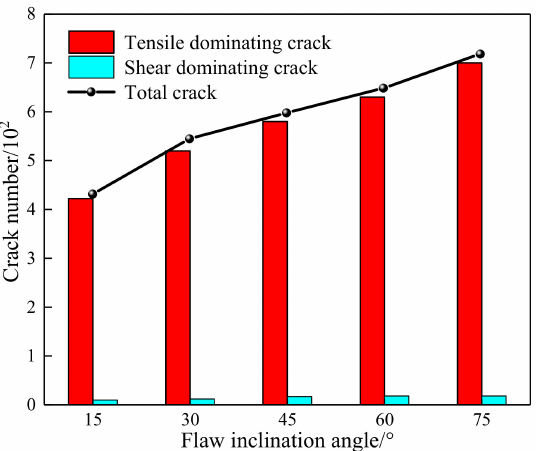
Figure 9. The number of cracks in sample models with different flaw inclination angles under peak